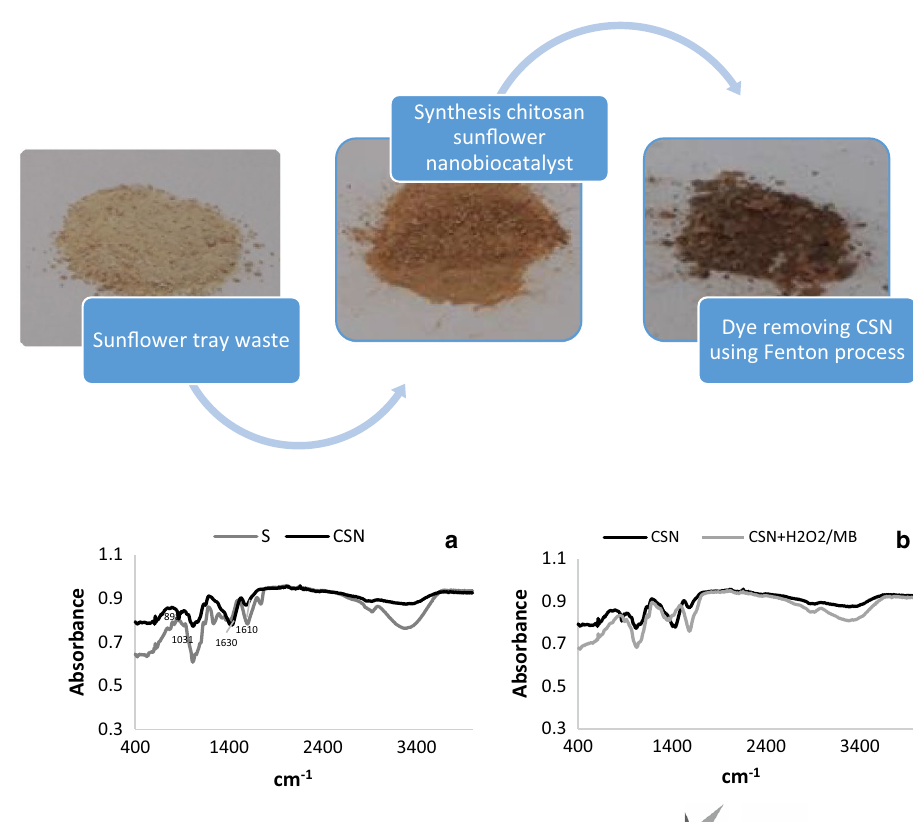
Fig. 3 Fenton process with CSN